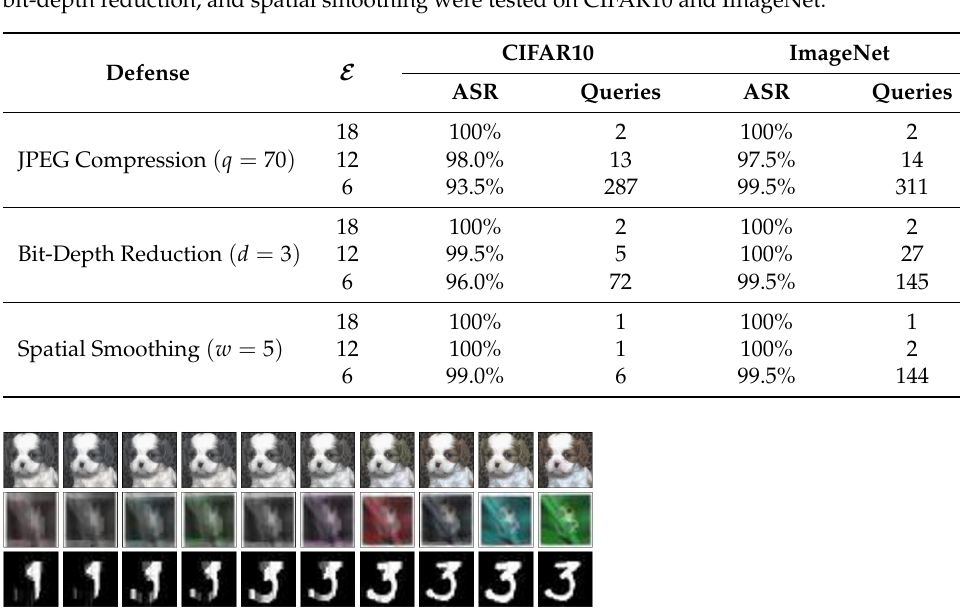
Table 3. QuEry Attack’s resistance to non-differentiable transformation defenses. JPEG compression, bit-depth reduction, and spatial smoothing were tested on CIFAR10 and ImageNet.